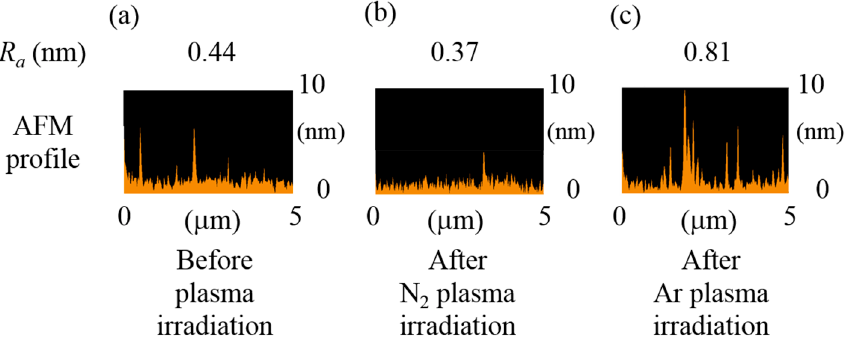
Figure 3. AFM profiles and surface roughness before ( a ) and after plasma irradiation ( b , c ) on the surface of CMP-treated PE-CVD oxide.